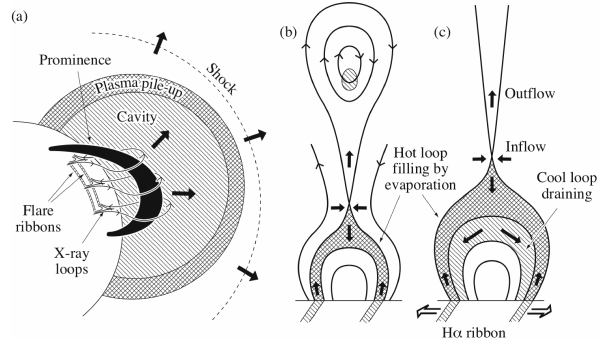
Figure 12. The speed of the solar wind as a function of latitude in polar coordinates from the Ulysses spacecraft during (a) solar min- imum and (b) solar maximum. Superimposed are coronal images from the Mauna Loa K coronameter, plus the EIT and LASCO in- struments on the Solar Dynamics Observatory (SDO) (from Meyer- Vernet, 2007).